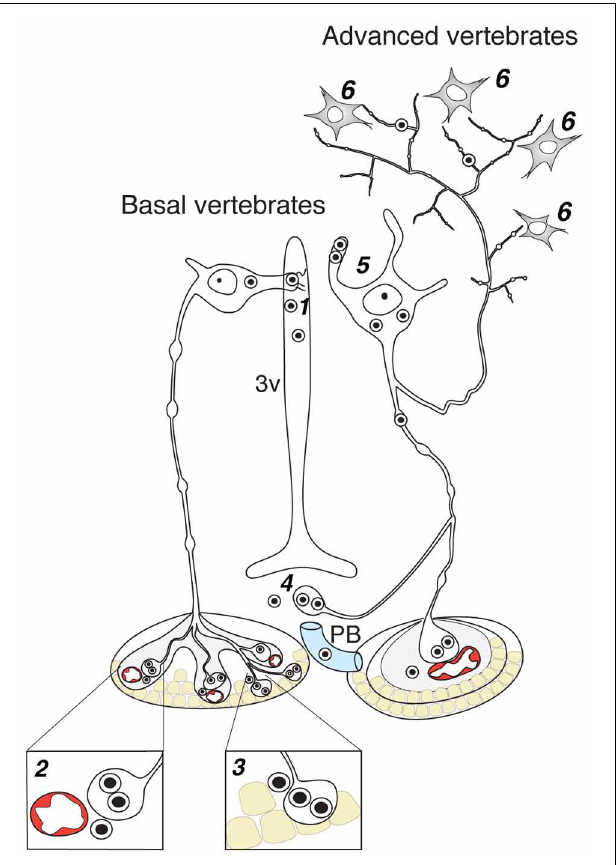
FIGURE 3 | Contacts of OT neurons and respective routes of OT release in the brain of basal and advanced vertebrates. 1—dendro-ventricular contacts (trans-ventricular route of OT action); 2—axo-vasal contacts (release into systemic blood circulation); 3—axo-adenar contacts (paracrine action on adenotrophes); 4—axovasal contacts with portal venes; 5—dendritic release; 6—axonal release. 3v, third ventricle; PV, portal